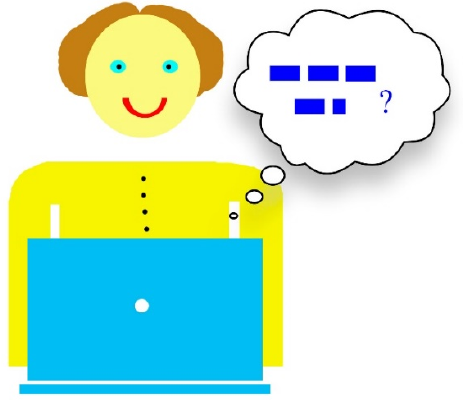
Figure 2. Average indicators for group communication, presented as an image.